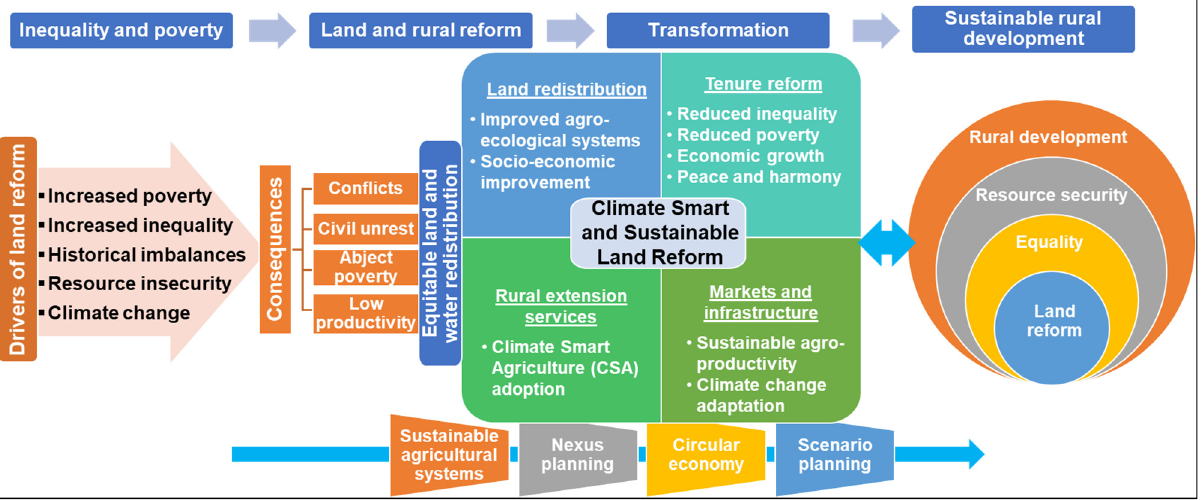
Figure 1. A nexus-based framework developed to drive the land reform and tenure agenda towards sustainable land redistribution and rural development. sustainable land redistribution and rural